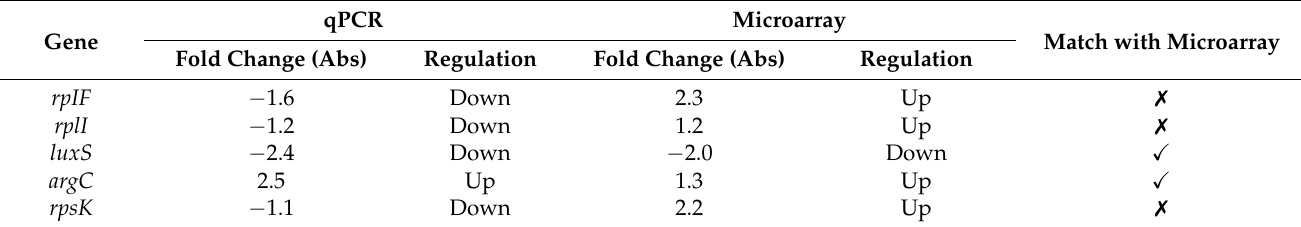
Table 3. A comparison between microarray and qPCR results for E (eugenol) versus C (control) for the genes, rpIF , rplI , luxS , argC , and rpsK , using an average of 4 housekeeping genes ( glpF , arc , gmk, and tpiA ) for normalisation.